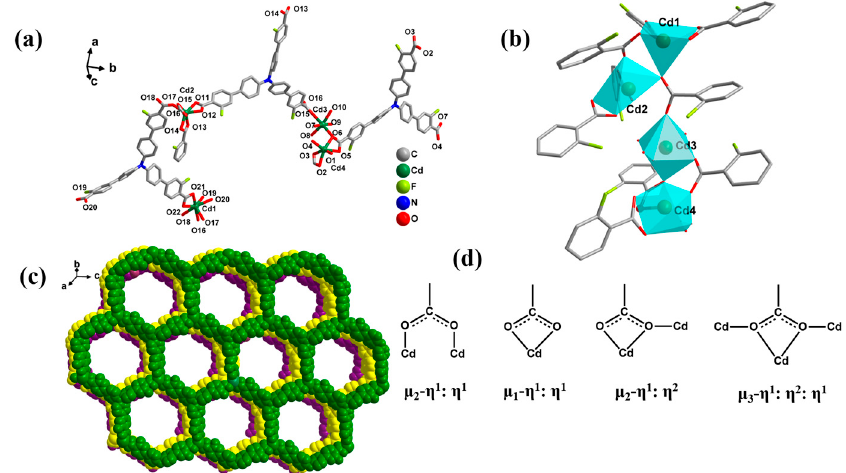
Figure 1. ( a ) The asymmetry of CdMOF-1 . ( b ) Coordination environment of Cd(II) center. ( c ) The view of 2D space filling mode of CdMOF-1 (for clarity, the H atoms were deleted). ( d ) The diverse coordination modes of H 3 TFBA in CdMOF-1 ( µ 1 – η 1 : η 1 , µ 2 – η 1 : η 1 , µ 2 – η 1 : η 2 , and µ 3 – η 1 : η 2 : η 1